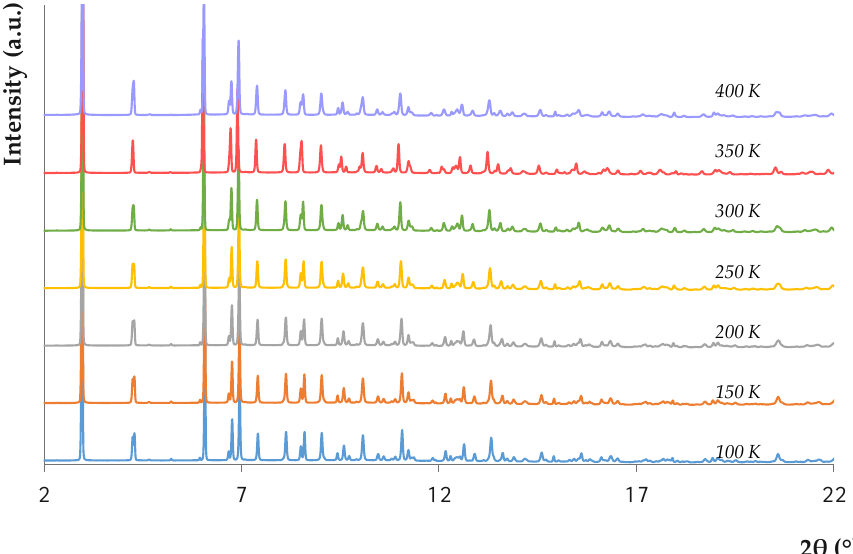
Figure 1. PXRD patterns of CIM-81 at different temperatures.